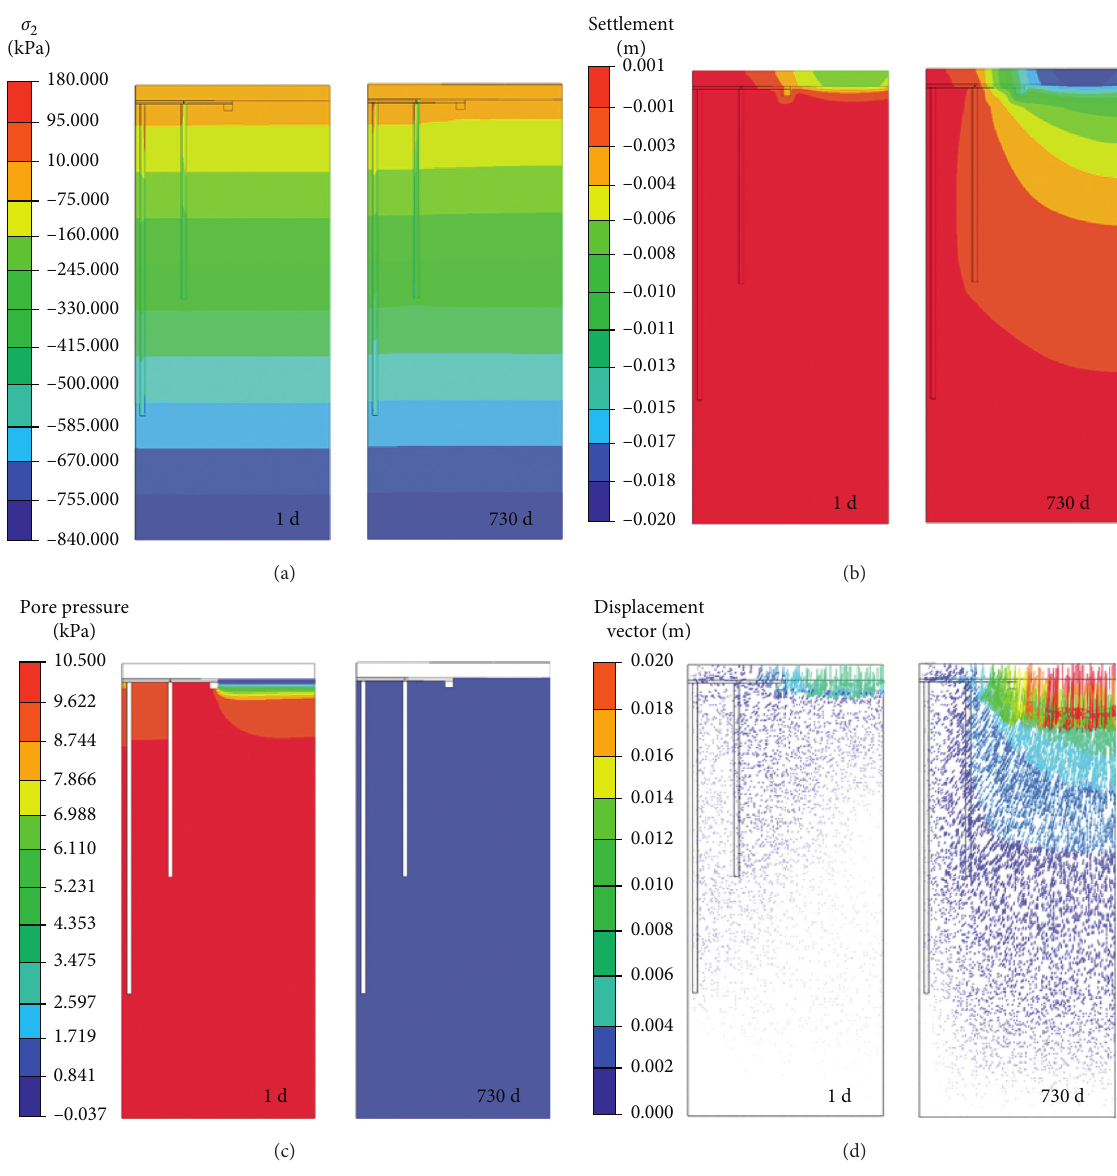
Figure 5: ABAQUS finite element simulation results: (a) vertical stress; (b) vertical displacement (c) pore pressure; and (d) displacement vector.